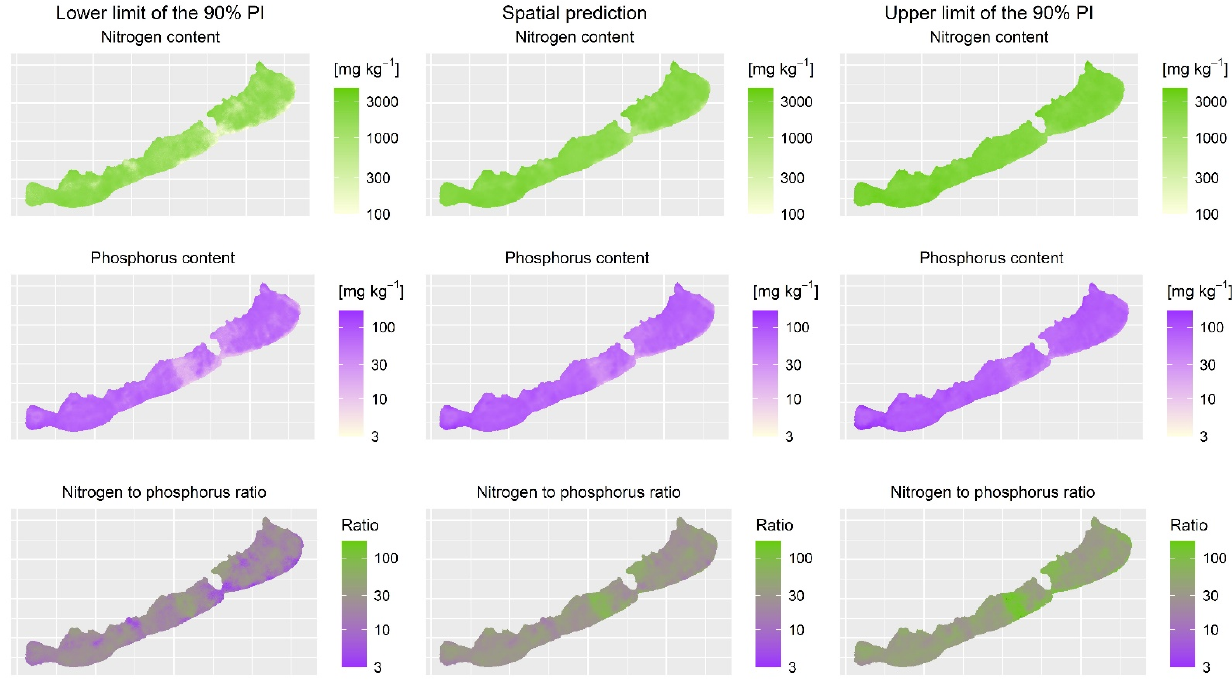
Figure 5. Point-support predictions for the nutrients nitrogen and phosphorus and for the nitrogen- to-phosphorus ratio ( middle column ) and the associated prediction uncertainty quantified by the upper ( right column ) and lower ( left column ) limit of the 90% prediction interval. Abbreviation: PI: prediction interval.